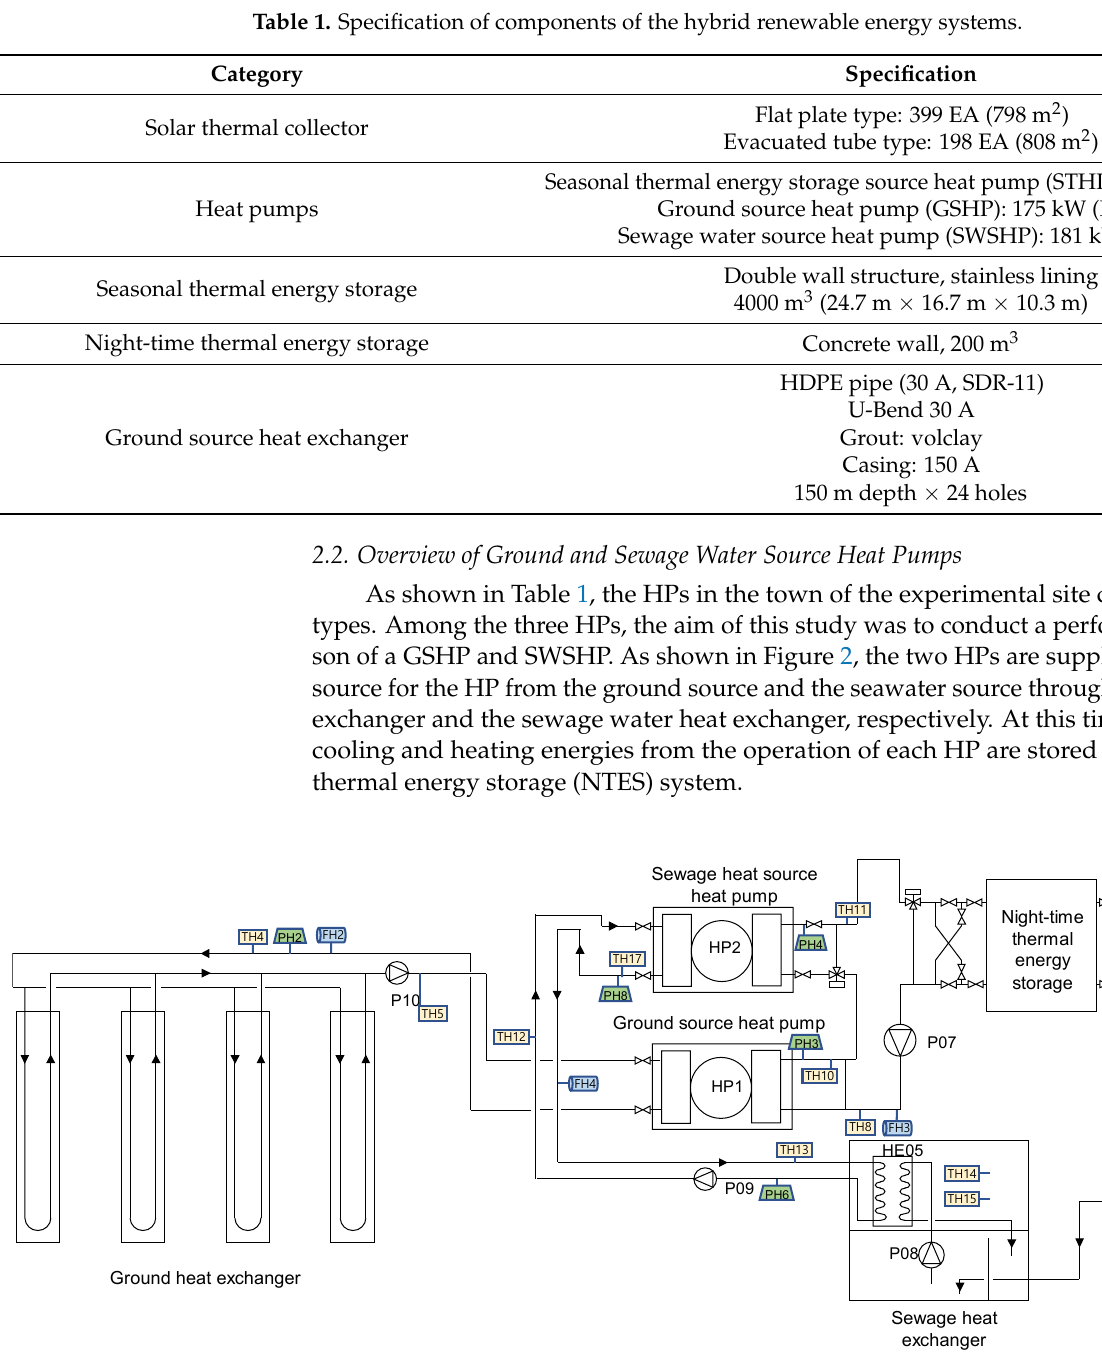
Table 1. Specification of components of the hybrid renewable energy systems.